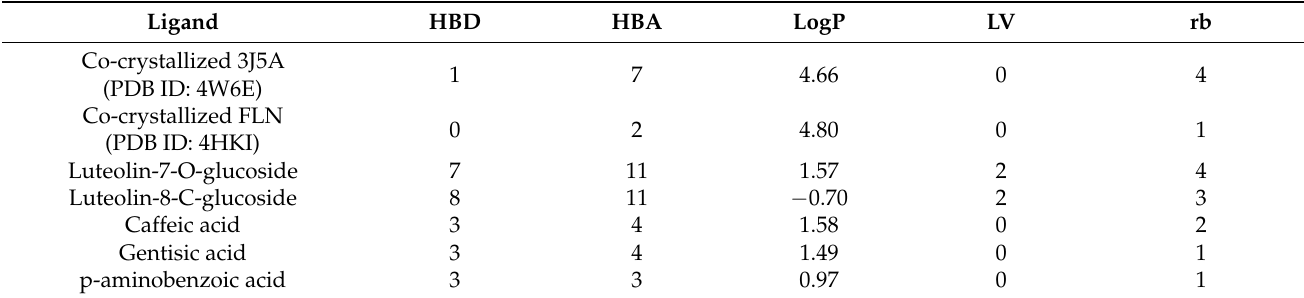
Table 3. Lipinski’s parameters for druggability